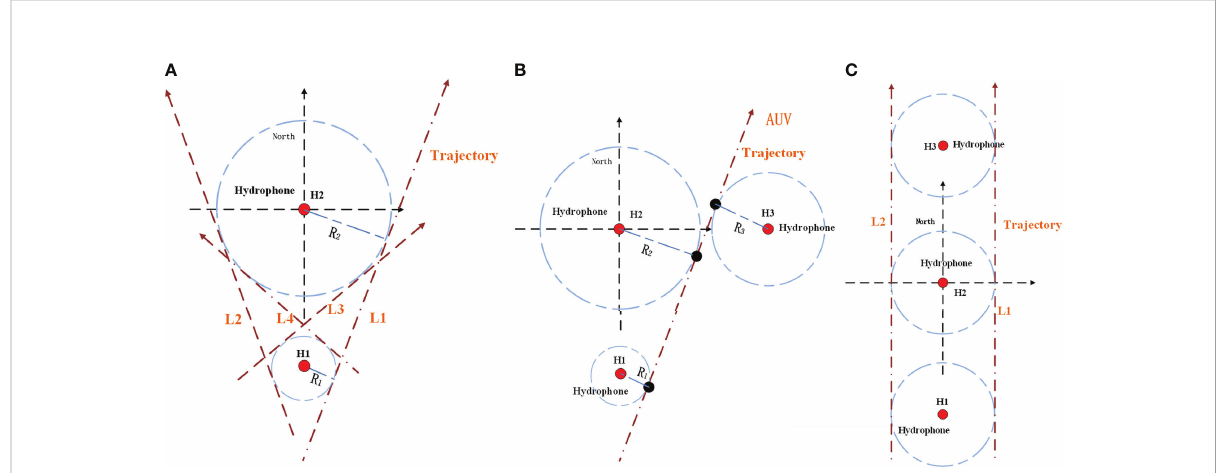
FIGURE 3 (A) Four possible trajectories of AUV; (B) AUV has only one possible trajectory; (C) Two possible trajectories of AUV.